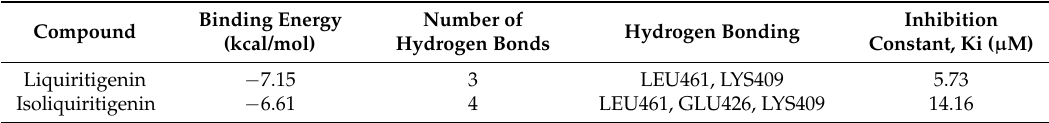
Table 4. Interaction of catalytic domain of PKC (PDB: 1XJD) with liquiritigenin and isoliquiritigenin using molecular docking software AutoDock 4.0.